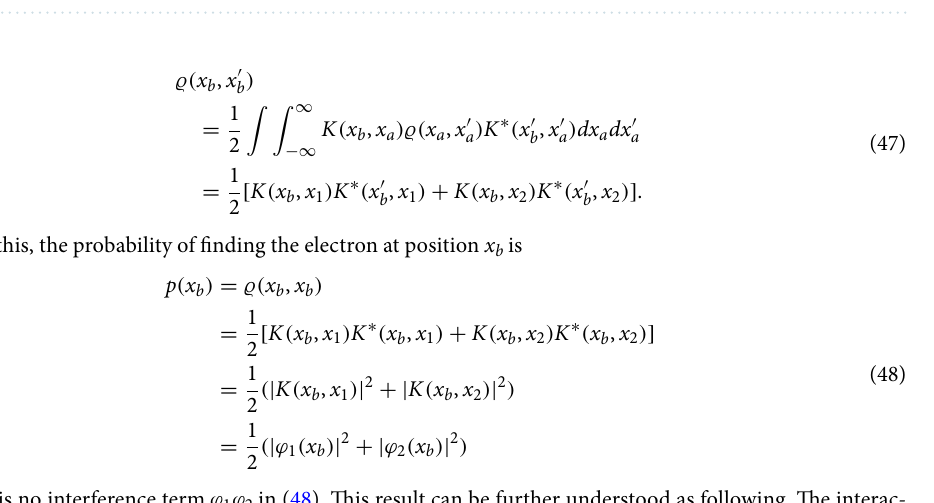
Figure 2. Modified double slit experiment discussed in page 7 of Ref. 42 . Here a light source is placed behind the double slit to assist detecting which slit an electron passes